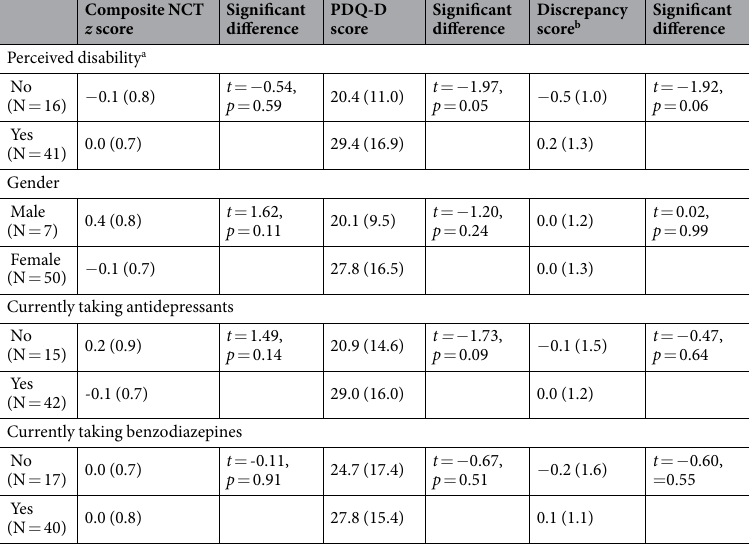
Table 3. Differences of subjective cognitive function (PDQ-D score) and objective cognitive function (composite NCT z score) and between groups of major depressed patients. a ≥ 1 SDS subscale ≥ 5 points. b Composite NCT z score subtracted by corresponding reversed PDQ-D z